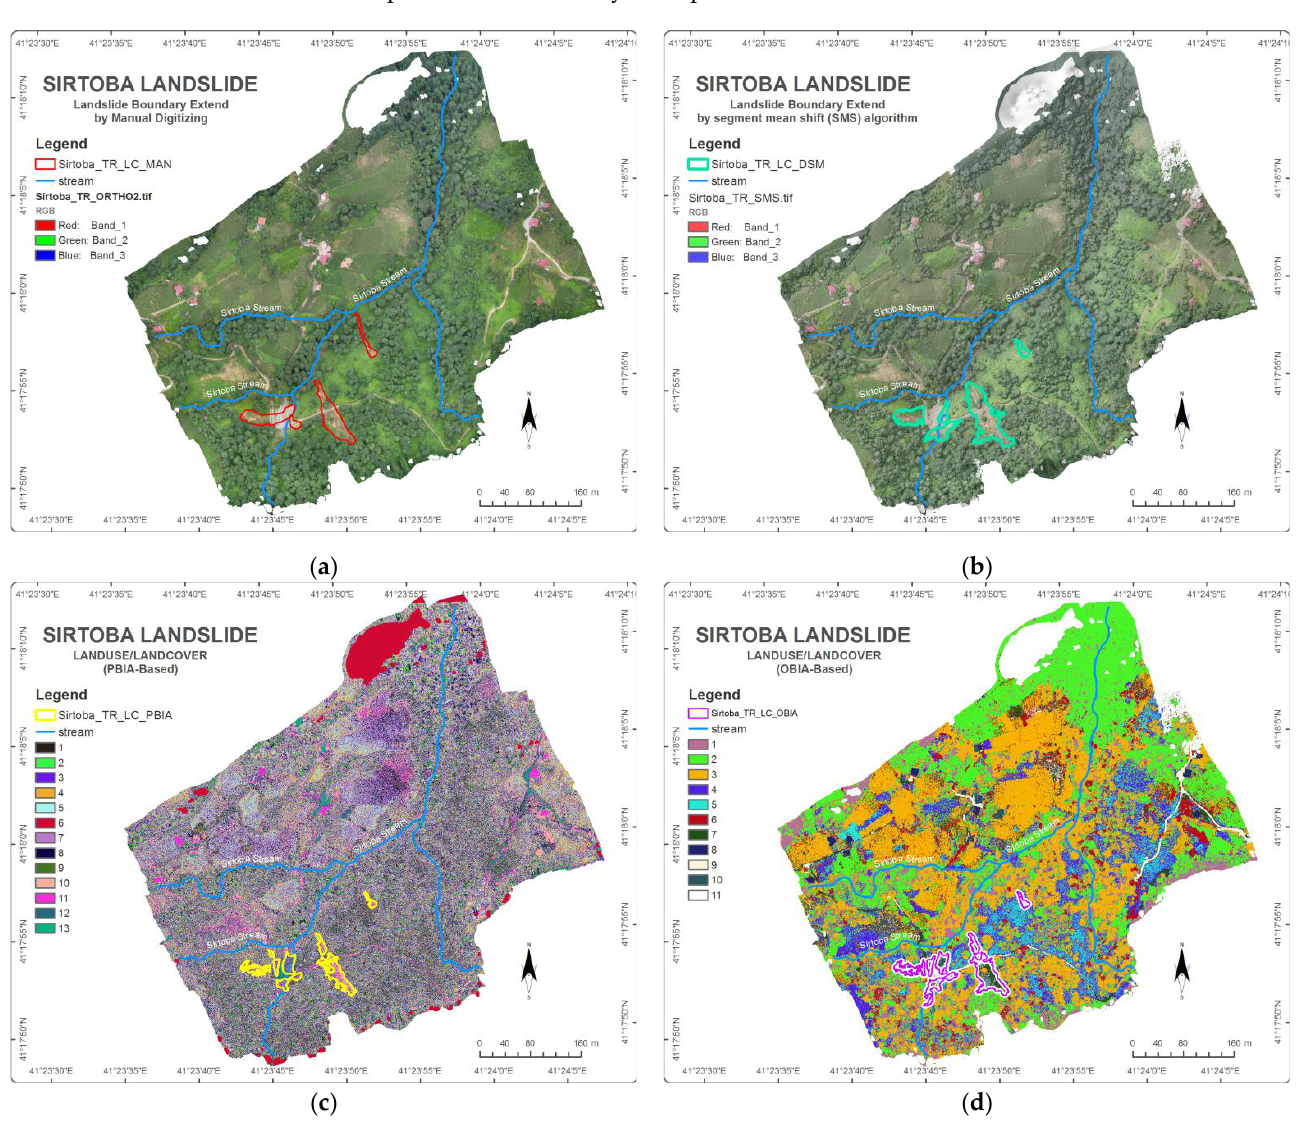
Figure 13. The results concerning Sirtoba in Turkey captured by the drone flight on 13 August 2022: ( a ) boundaries of affected area, manually digitized; ( b ) segment mean shift (SMS) algorithm; ( c ) ISO Cluster unsupervised classification (initial based on the orthomosaic); and ( d ) ISO Cluster unsupervised classification (initial based on the SMS). Table 5. The statistics produced by each method for the Turkish